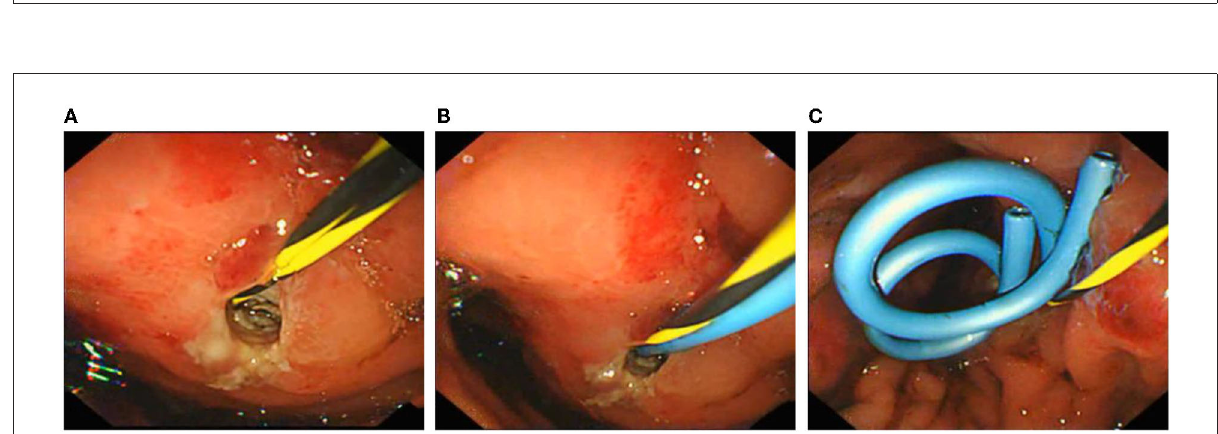
FIGURE3 Endoscopic ultrasonography-guided cyst puncture and drainage of pseudocysts through the gastric wall. (A) The cyst site was punctured and dilated, and the nasal cyst tube was inserted. (B) Placement of the first double pigtail stent. (C) Two double pigtail stents and a nasal cyst tube were placed in a good